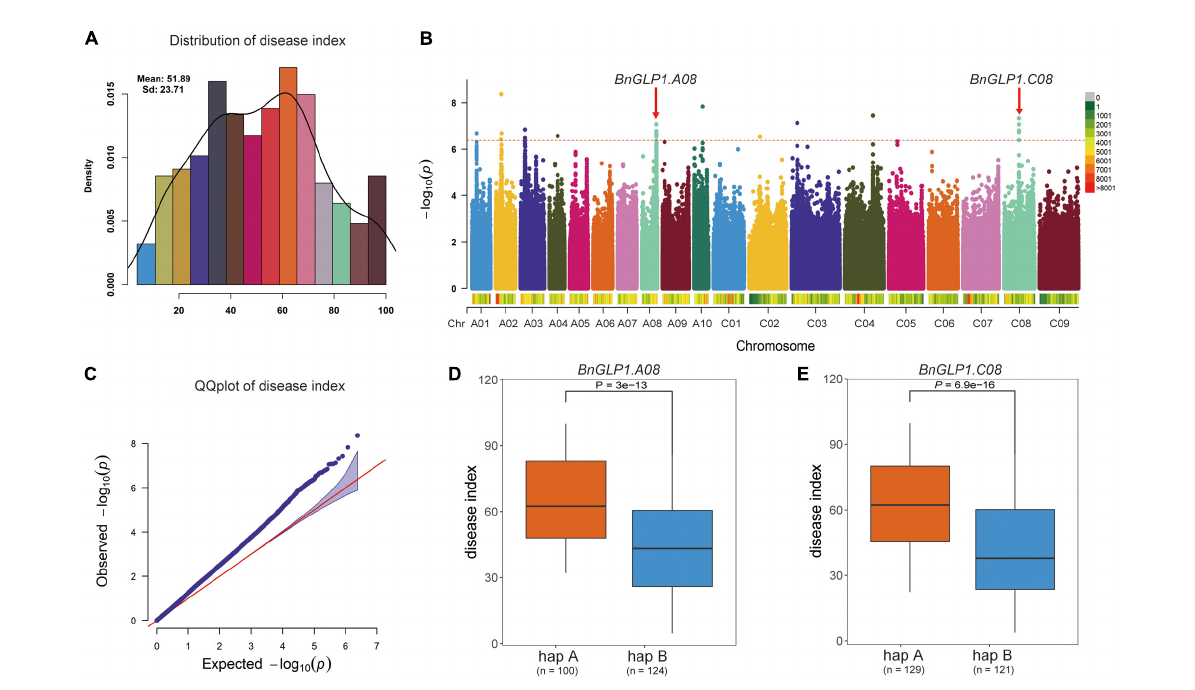
FIGURE7 Both BnGLP1.A08 and BnGLP1.C08 are associated with Sclerotinia sclerotiorum resistance in Brassica napus . (A) Frequency distribution of disease index of 274 B. napus accessions. (B) Manhattan plot of the disease index from association analyses by FarmCPU model. Each point represents a SNP, and the SNP that exceeds the threshold (red dotted line) –log 10 (1/ n ) = 6.377 is significant. (C) QQ plot for the disease index from association analyses. (D,E) Boxplots for disease index based on the two haplotypes of BnaGLP1.A08 (D) and BnaGLP1.C08 (E) . The phenotypic differences between groups were tested using a two-tailed t -test ( P <